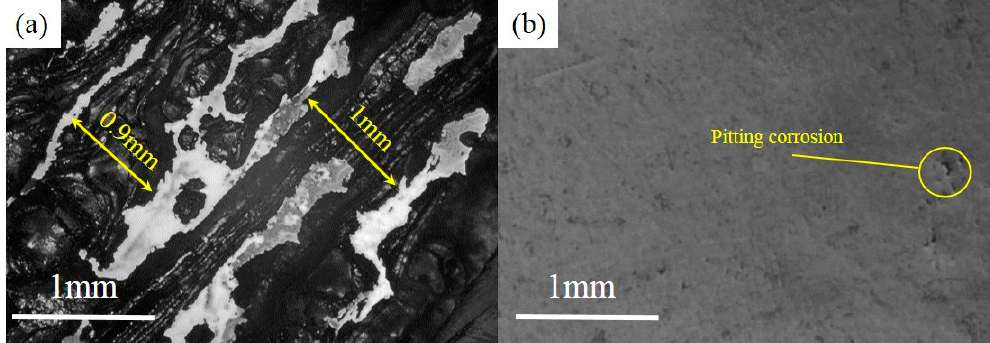
Figure 9. Corrosion of sample surface in high voltage range. ( a ) Sample of 316 L stainless steel. ( b ) Sample of NbMoTaW